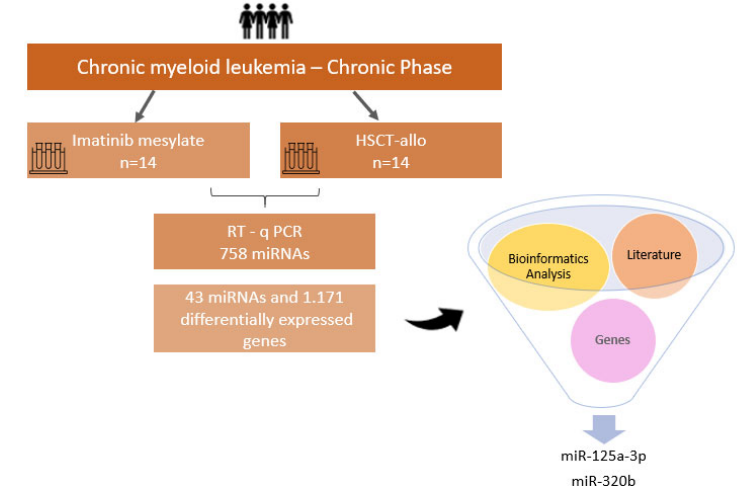
Figure 5. Summary of methodology steps and main results .